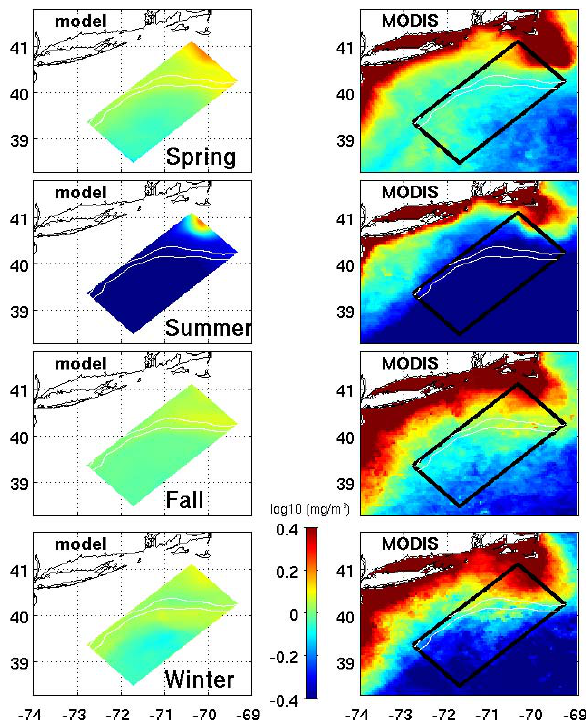
Figure 4. Seasonal surface chlorophyll comparisons based on simulated and observed 4-year mean results. Shown in the left column are model results (taken from the top layer of model) and those in the right column are MODIS observed results, with the model domain overlaid (black box). 100 and 200 m isobaths are also shown (white curves).